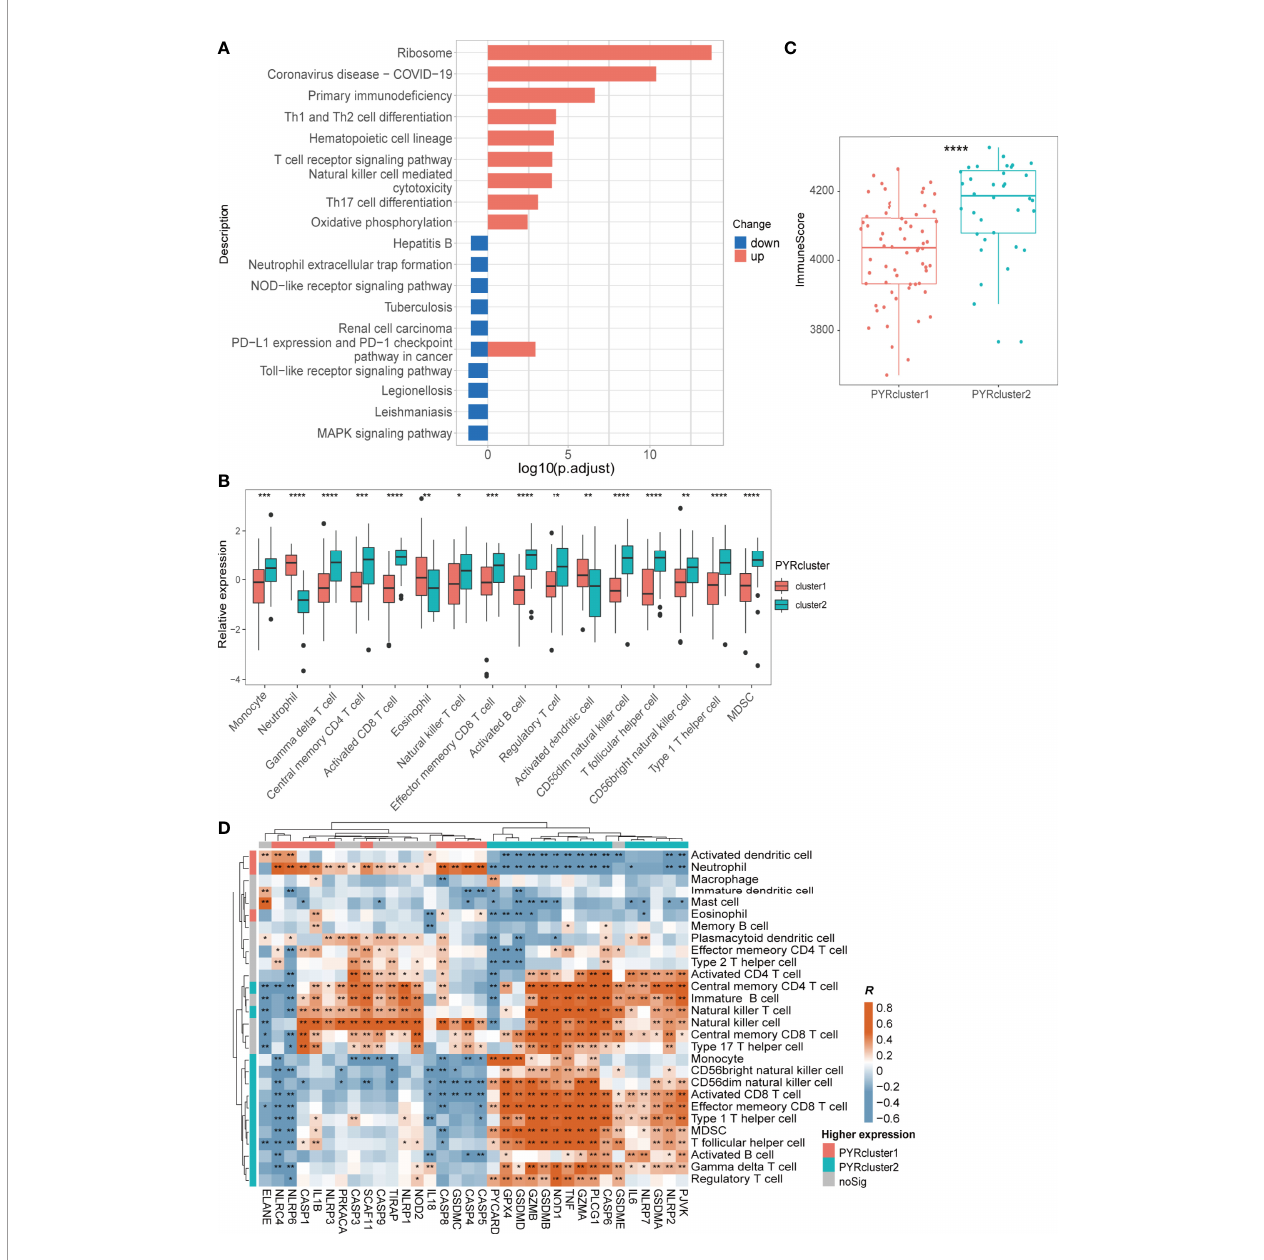
FIGURE 4 | (A) Kyoto Encyclopedia of Genes and Genomes (KEGG) enrichment of 570 DEGs Between two PYRclusters, “ up ” means these pathways of PYRcluster2 were upregulated when compared to PYRcluster1; “ down ” means these pathways were downregulated. (B) Leukocytes with signi fi cantly different expression levels among PYRclusters. (C) ImmuneScore calculated by “ estimate ” package between two PYRclusters. (D) Pearson ’ s correlation between expressions of 35 pyroptosis-related genes and abundance of leukocytes, R value represents the Pearson ’ s correlation coef fi cient. Annotated bars above and to the left indicate in which PYRcluster each pyroptosis-related gene or leukocyte is highly